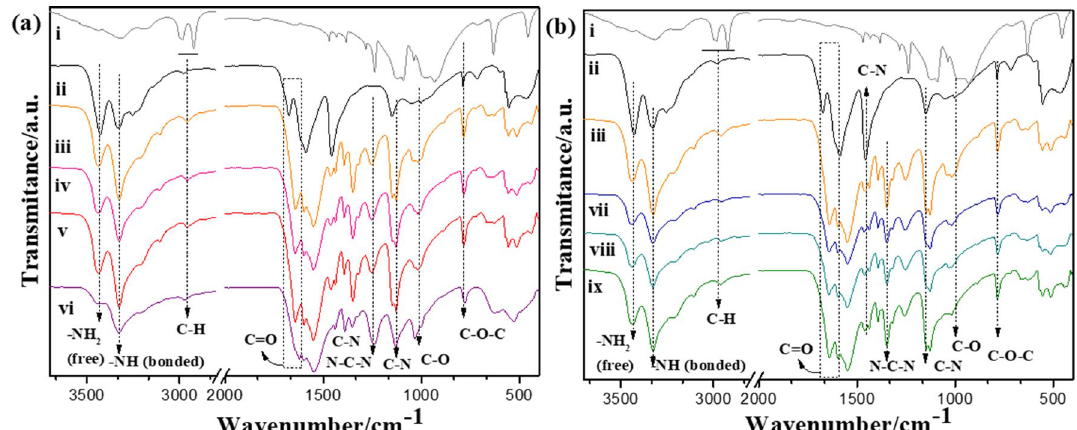
Figure 2. Normalized FTIR spectra in ( a ): (i) paraformaldehyde, (ii) urea (iii) pure polymer UF, (iv) UFZO 0.5, (v) UFZO 1, (vi) UFZO 2 and in ( b ): (vii) UFZS 0.5, (viii) UFZS 1 and (ix) UFZS 2.